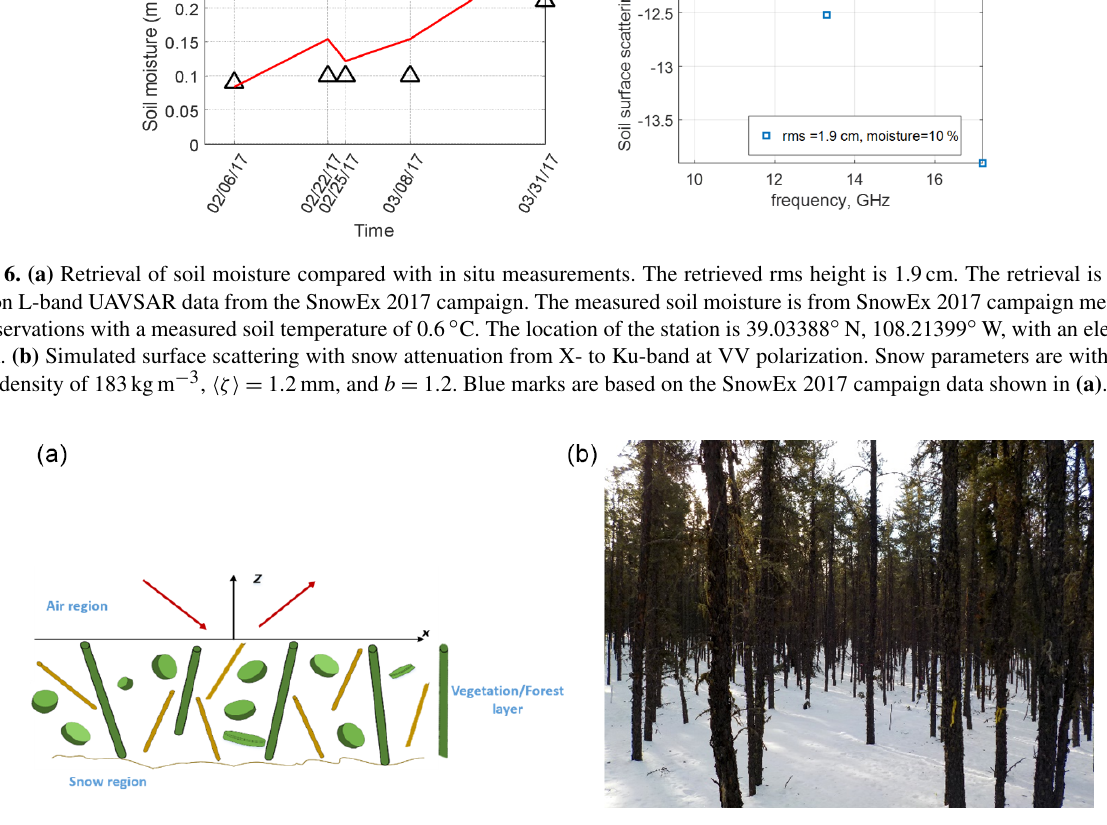
Figure 7. (a) RTE assumption: uniformly randomly positioned scatterers which are statistically homogeneous. (b) Illustration of trees for a forest with snow cover beneath. The picture was taken on 14 March 2017 in a Jack Pine stand situated in the Boreal Ecosystem Research and Monitoring Sites (BERMS), Saskatchewan,